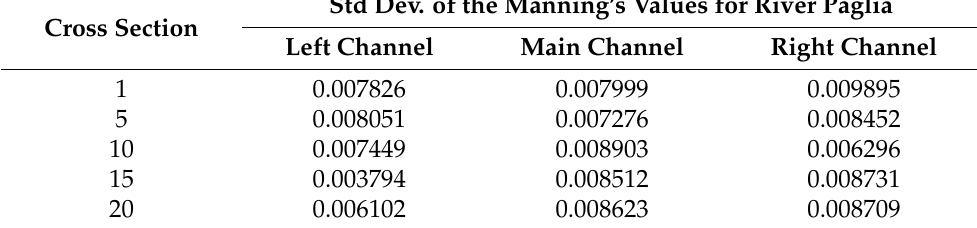
Table 3. Standard deviations of the Manning’s values obtained by the 25 executions of the (1 + 1)-ES algorithm for the case of study ‘river Paglia’. For the sake of readability, five cross-sections were reported, though the magnitude of the standard deviations is roughly the same for all the other cross-sections.